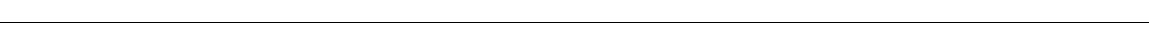
Fig. 2 Goniophotometry and three-dimensional single-molecule orientation measurements. a – f Emission angle distributions of polymers with donor – acceptor ratios of ~8:1 and distances of ~1.5 – 2 nm were determined using calibrated power meters. b , e Isotropic acceptor emission (red, e ) was observed after nearly perpendicular donor excitation in foils with random acceptor orientations. c , f When using samples with aligned acceptors instead, most of the light was emitted perpendicular (red, f ) to the acceptor dipole moments, while nearly isotropic residual donor emission (green, c ) demonstrates that the light-harvesting donors were still randomly orientated. Approximately 90% of the acceptor photons were re-directed into an angle range suitable for total re fl ection optical waveguiding with refractive indices of 1.5 or 1.9 (for details see Supplementary Figure 2, Supplementary Table 2, and Supplementary Note 2). The three acceptor distributions in f are obtained after (i) donor excitation and EET to aligned acceptors, (ii) direct excitation of aligned acceptors, and (iii) calculating an ideal cos 2 -distribution expected from perfectly aligned molecules. d When exciting randomly oriented dyes directly, as in conventional luminescent solar concentrators (cf. Fig. 1c), actually more light is emitted in unfavorable directions parallel to the excitation. Intensities at experimentally inaccessible detection angles were linearly extrapolated and values for angles > 180° were mirrored from the values at 0° – 180° (dotted lines in b – f ). In b , c , e , and f , the scale denotes the angle with the transition dipole moment vector of aligned acceptors in stretched foils (Fig. 2a). In d , the scale denotes the angle with the excitation direction (inset in Fig. 2d). g – p Three-dimensional orientations of single acceptor molecules were determined by polarization modulated excitation with two different incident light directions (insets in g , h , l , m , Methods). i , k , n , p This yielded two different projections of the transition dipole moment orientation for individual molecules in samples with random ( g , i and h , k ) and aligned ( l , n and m , p ) acceptors, respectively. j , o From the two-dimensional projections i , k and n , p , the distribution of three-dimensional dipole orientations, j and o , for random and aligned acceptors are computed, respectively. These observations con fi rmed parallel alignment of the acceptor molecules in stretched foils in all three